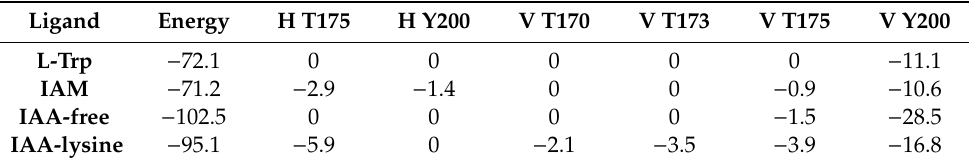
Table 1. Energy values of interaction between selected Psn23 MatE amino acids and several putative ligands. The value for each amino acid residue represents the energy of the single bond (expressed as kcal / mol). H = hydrogen bonding; V = van der Waals forces. Ligand Energy H